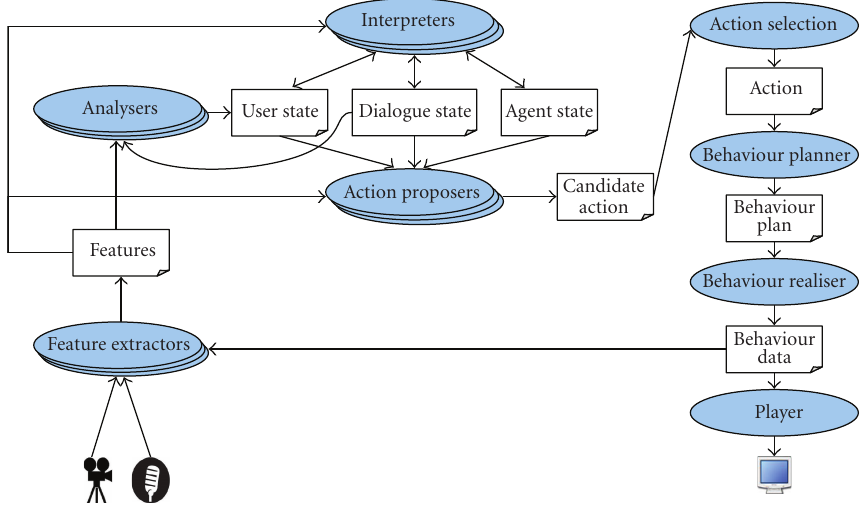
Figure 11: Conceptual message flow graph of the SEMAINE